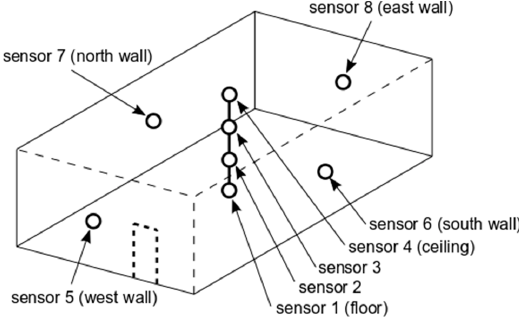
Figure 5. Solar maximum power point tracking (MPPT) outputs depending on temperature and solar irradiance. ( a ) MPPT voltage; ( b ) MPPT power generation. As previously mentioned, the total battery capacity has to be easily manageable to